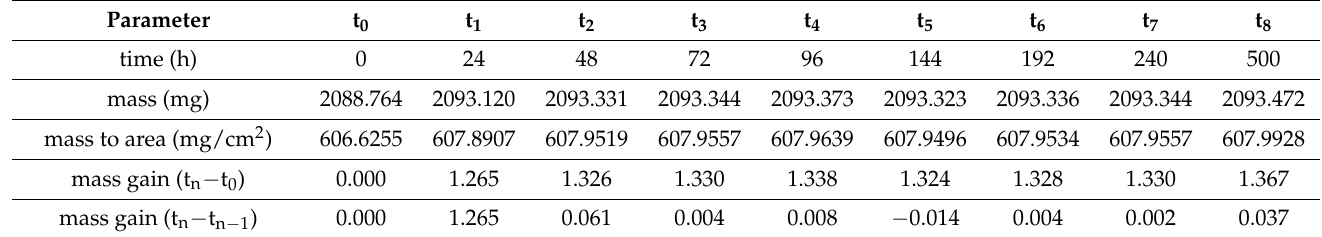
Table 2. Mass gain after steam oxidation at 700 ◦